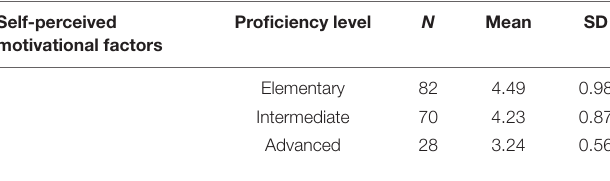
TABLE 9 | Descriptive statistics of the participants’ self-perceived motivational factors in terms of English proficiency.